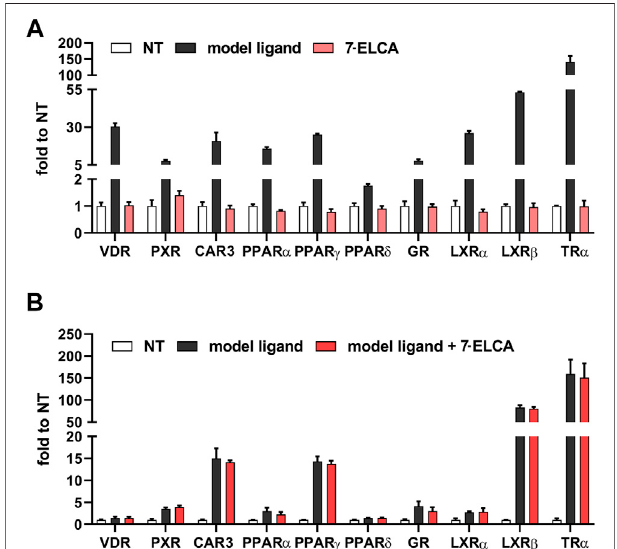
FIGURE 7 | Speci fi city of 7-ELCA in agonistic (A) and antagonistic (B) assays performed on transiently co-transfected HepG2 cells with luciferase reporter constructs in combination with appropriate expression vectors as indicated in Materials and Methods . (A) Cells were treated with 7-ELCA for 24 h. The following compounds were used as model ligands: VDR agonist 1 α ,25(OH) 2 vitaminD 3 (100 nM), PXR agonist (rifampicin 10 µM), human CAR agonist (CITCO 10 µM), PPAR α agonist feno fi brate (10 µM), PPAR γ agonist rosiglitazone (10 µM), PPAR δ agonist GW501516 (10 µM), GR agonist dexamethasone (100 nM), LXR α and LXR β agonist GW3964 (10 µM), and TR agonistthyroxin(10 µM). (B) Thesamemodel ligandsofthenuclearreceptors were used in combination with 7-ELCA in the same assays; VDR agonist 1 α ,25(OH) 2 vitaminD 3 (10 nM), PXR agonist rifampicin (1 µM), human CAR agonist CITCO (1 µM), PPAR α agonist feno fi brate (1 µM), PPAR γ agonist rosiglitazone (1 µM), PPAR δ agonist GW501516 (1 µM), GR agonist dexamethasone (50 nM), LXR α and LXR β agonist GW3965 (1 µM) and TR agonist thyroxin (1 µM) were used. Data were normalized to Renilla luciferase activityandareexpressedasfoldactivationrelativetocontrol(nontreated,NT) cells. Values are presented as the means ± SD of three independent